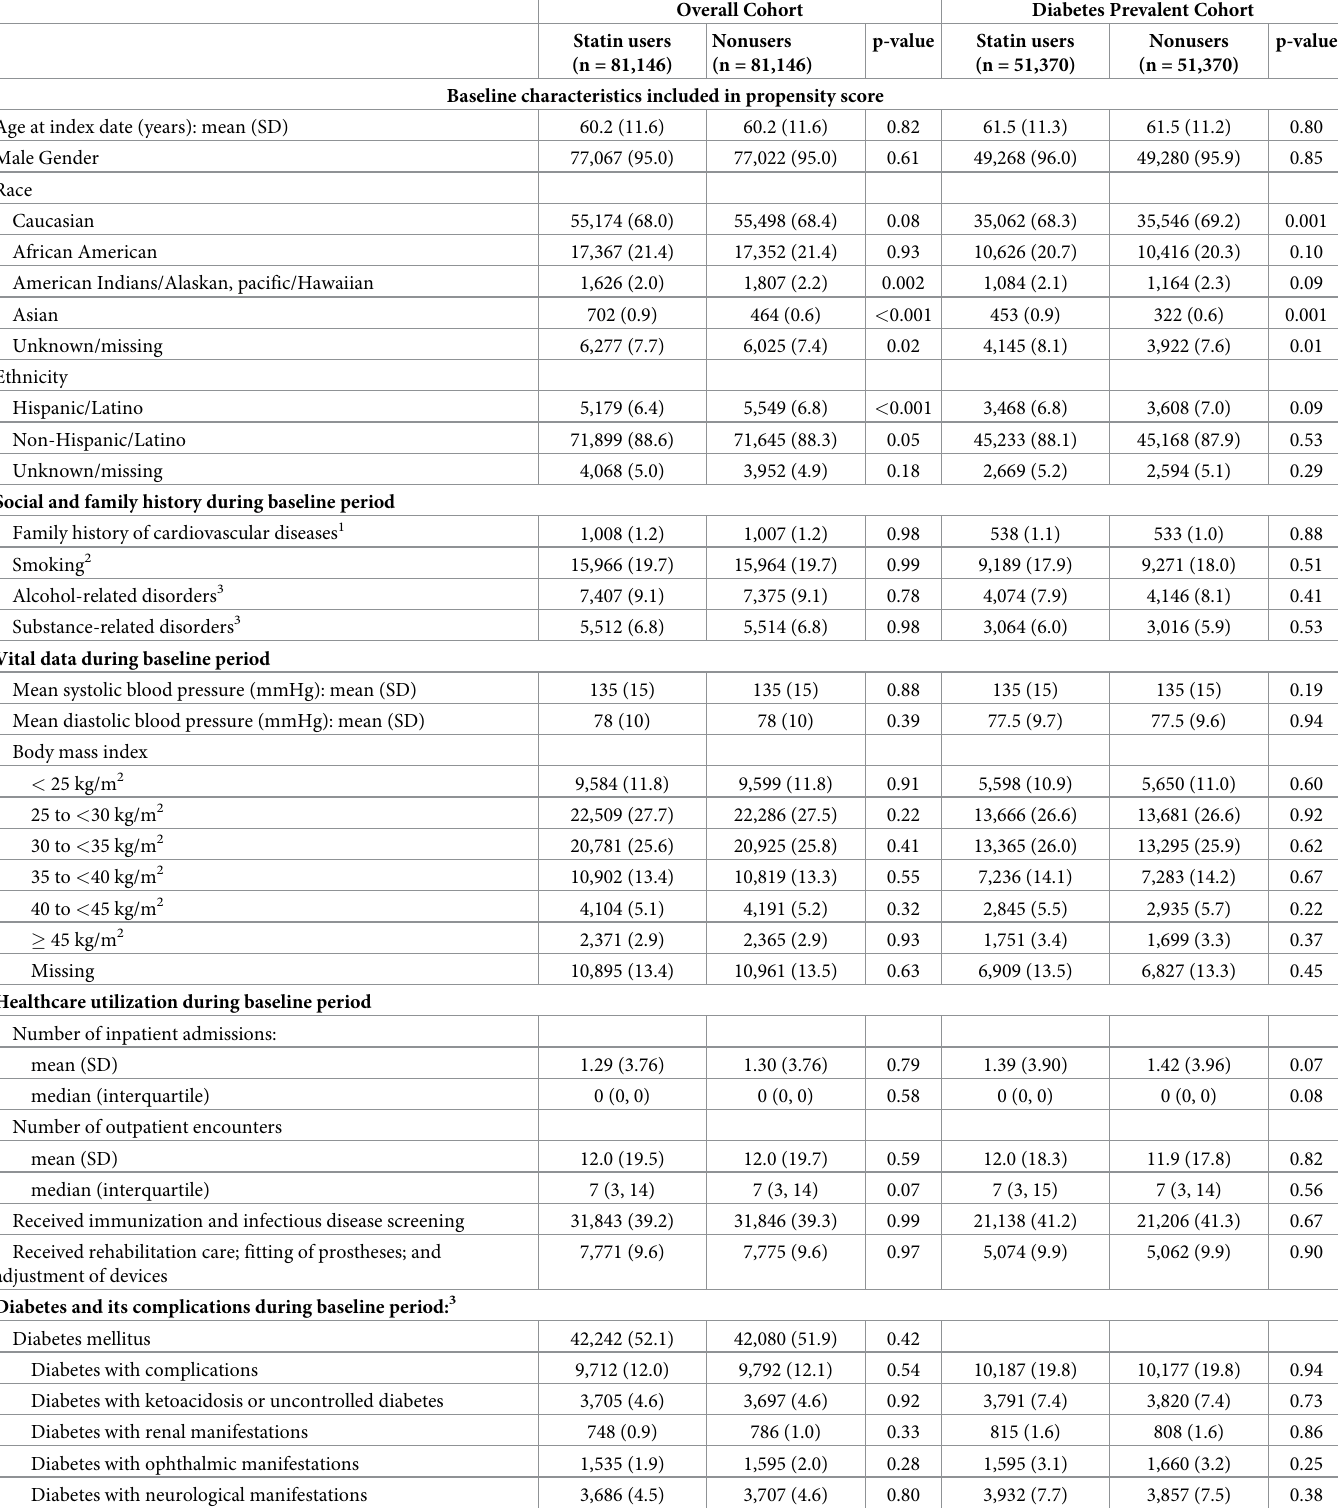
Table 1. Baseline characteristics of propensity score-matched statin users and active